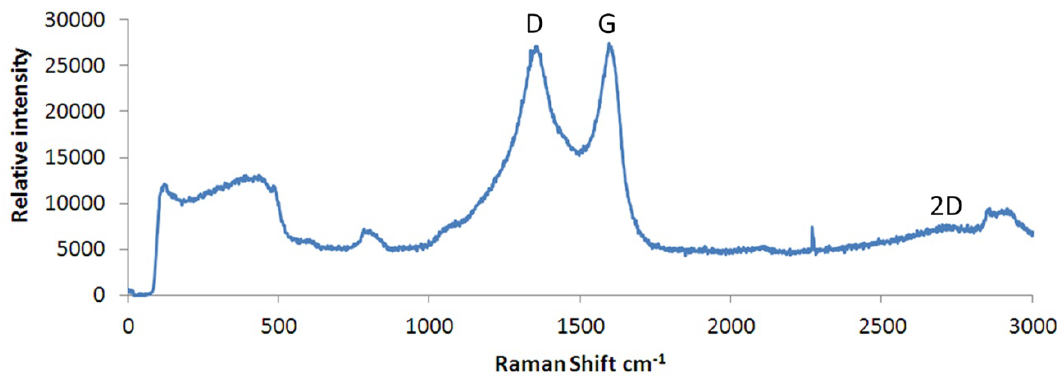
Figure 4. Raman spectra of graphene prepared on a quartz substrate.